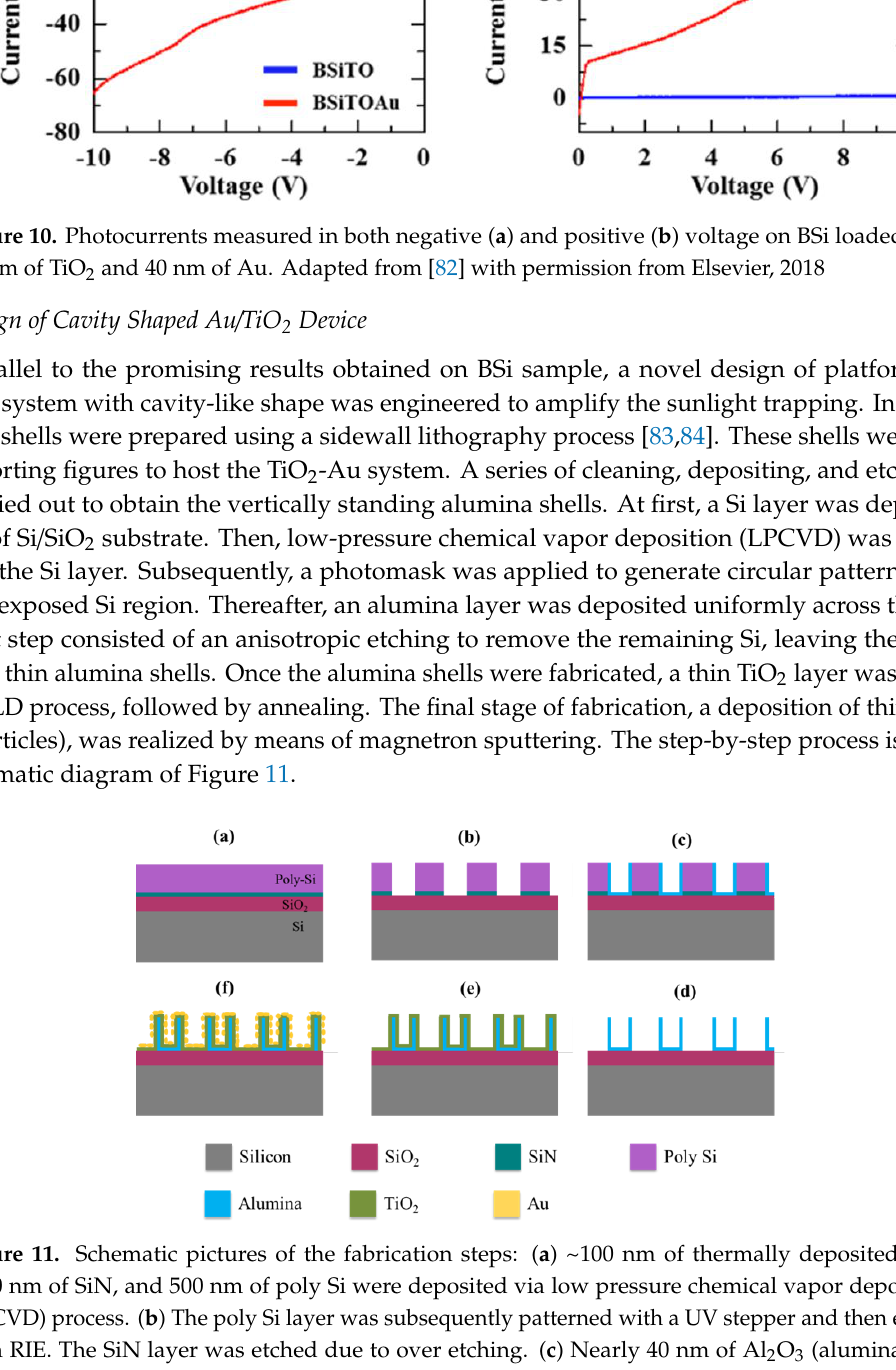
9 of 18 Figure 9. Comparison of optical spectra obtained from: ( a ) FSi and BSi; and ( b ) BSi, BSiTiO 2 (BSiTO), and BSiTiO 2 -Au 40 nm (BSiTOAu40) samples. The arrow marks indicate the enhancement of absorption in the BSiTOAu40 sample after adding the Au nanoparticles. Adapted from [82] with permission from Elsevier, 2018 Following the fabrication of the etched Si substrate, the photocatalyst TiO 2 was deposited. A thin film of 40 nm was grown using ALD process. Then, Au was deposited on top of the TiO 2 film. The thickness of the Au was kept within 40 nm which provides with a good compromise between the light absorption intensity and electrical conductivity of the photocatalyst. To assess the performances of the device, absorption spectroscopy and photocurrent measurement were carried out. Figure 9b shows that the addition of 40 nm of Au improved the absorption in the visible range at around 480 and 550 nm (marked by the arrows in the Figure 9b). To further confirm the efficient light absorption proprieties of BSi, a photocurrent measurement was carried out to evaluate the device generated current by photoexcitation. A Keithley source meter, consisting of a four-probe measurement setup, was utilized to capture the photo-induced current. In this experiment, the current was monitored with light off (using dark room) and light on using a broad band light source (Xenon lamp). To underline the contribution of the plasmonic Au particles, two samples were considered: a clean BSi sample coated with TiO 2 (BSiTO) and a coated BSiTO sample loaded with Au nanoparticles (BSiTOAu). The deposited Au material was monitored to obtain nanostructures with various shapes and sizes in order to enhance the light absorption through plasmonic effect. As one can notice in Figure 10, the resulted photocurrent greatly increased for BSiTOAu sample, indicating a significant effect of Au nanostructures. Hereby, these results